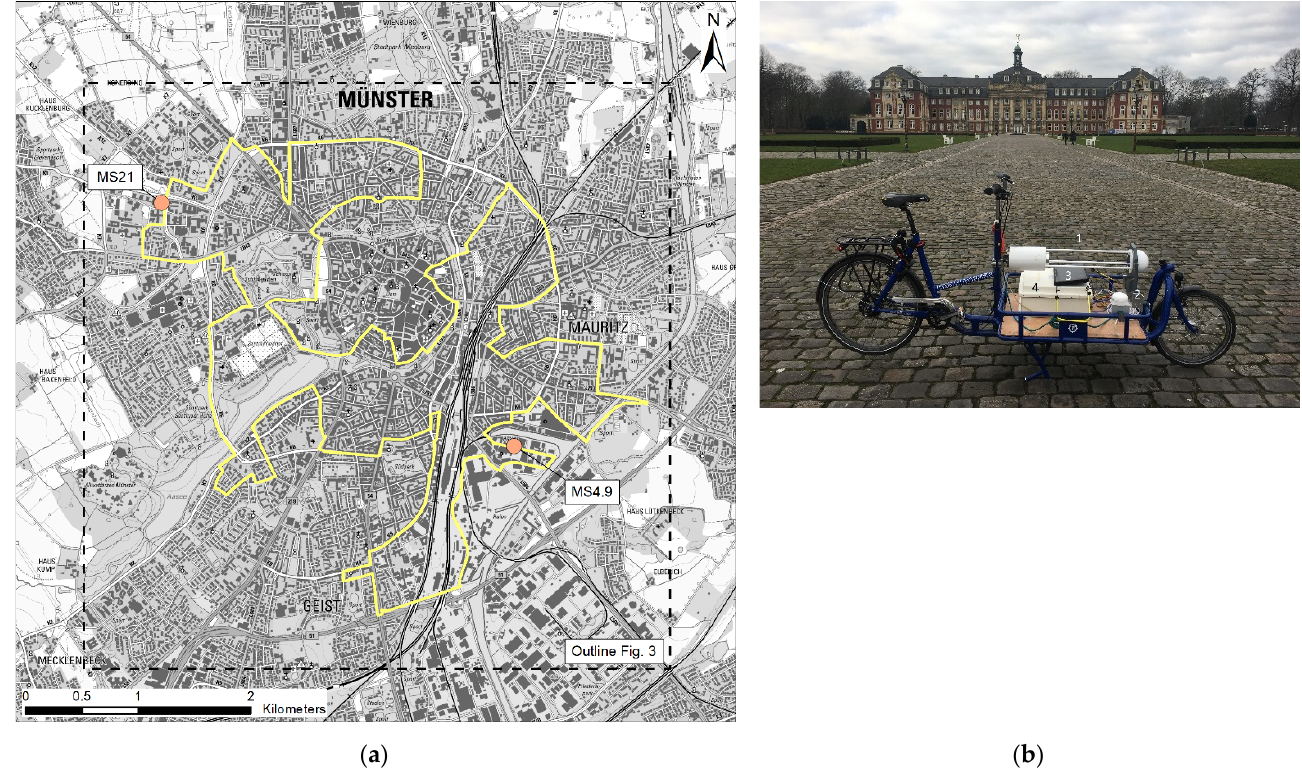
Figure 1. ( a ) City route for mobile measurements (MM) and location of stationary measuring sta- tions MS21 and MS4.9: Map source: DTK25, 1:25,000, © Geobasis NRW 2017,